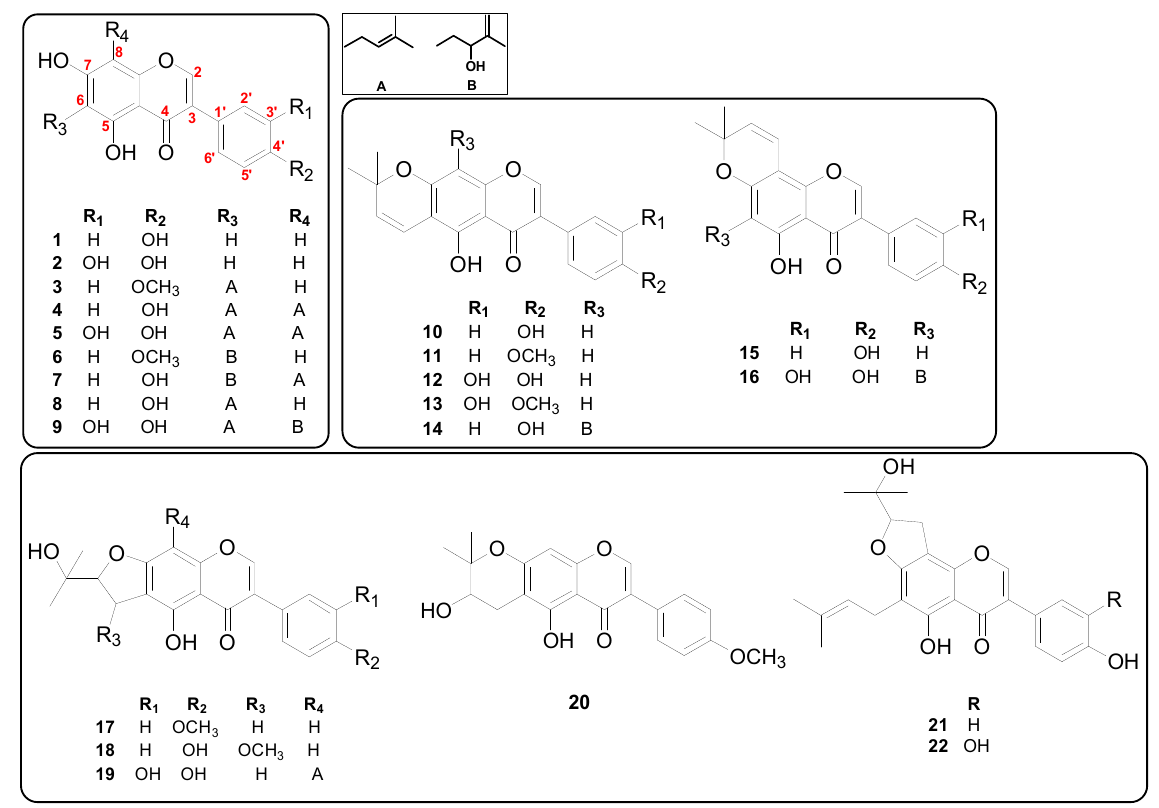
Figure 1. Chemical structures of 22 isoflavones tested for antibacterial activities in the present study.